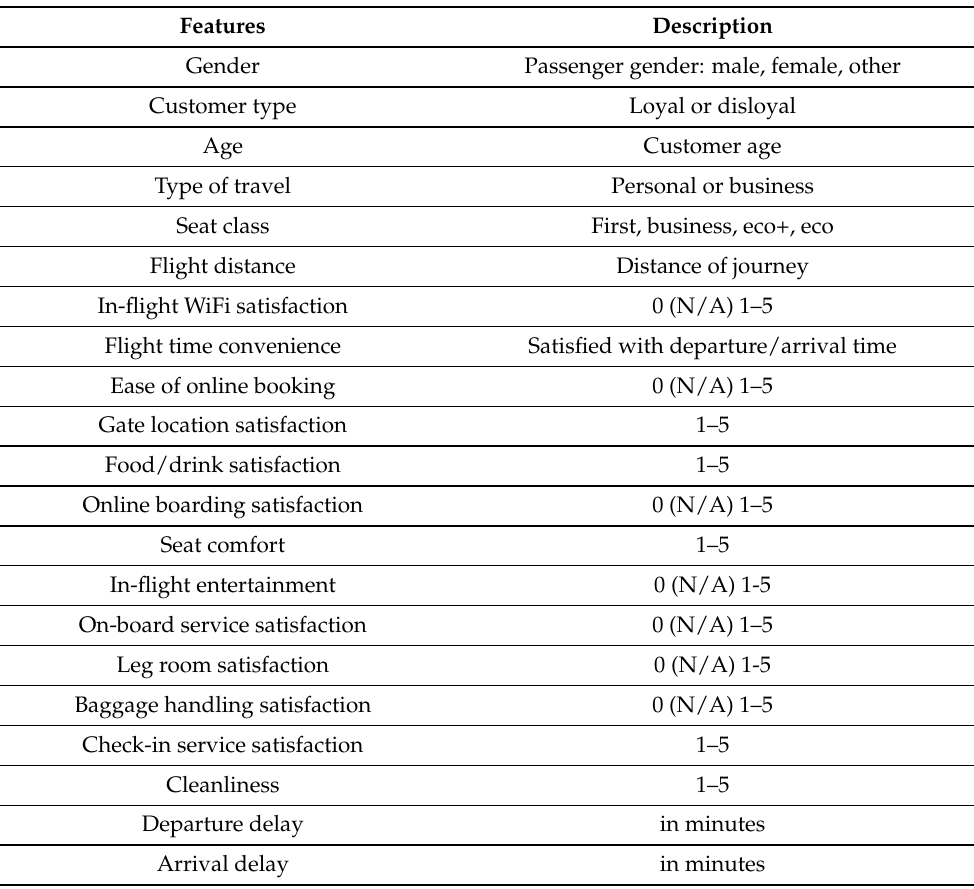
Table 4. Airline features available for